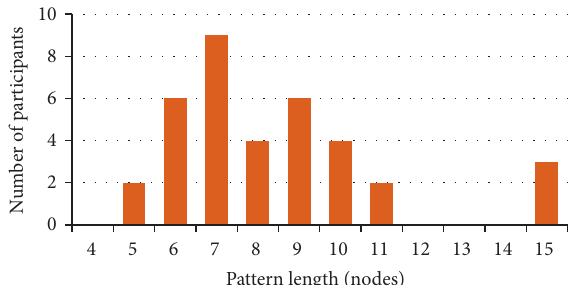
Figure 5: Length of lock patterns created by participants using the enhanced lock